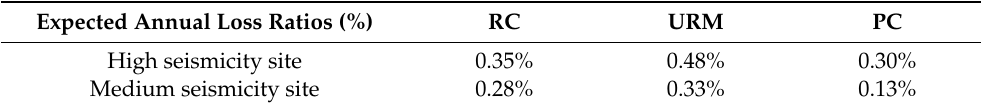
Table 1. Expected annual loss ratios obtained by O’Reilly et al. [46] for three buildings representative of the Italian school building